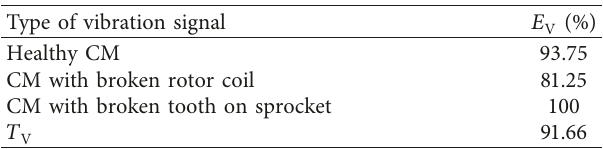
Table 5: The results of recognition of vibration signals—the sum of RSoV and the LDA classifier were